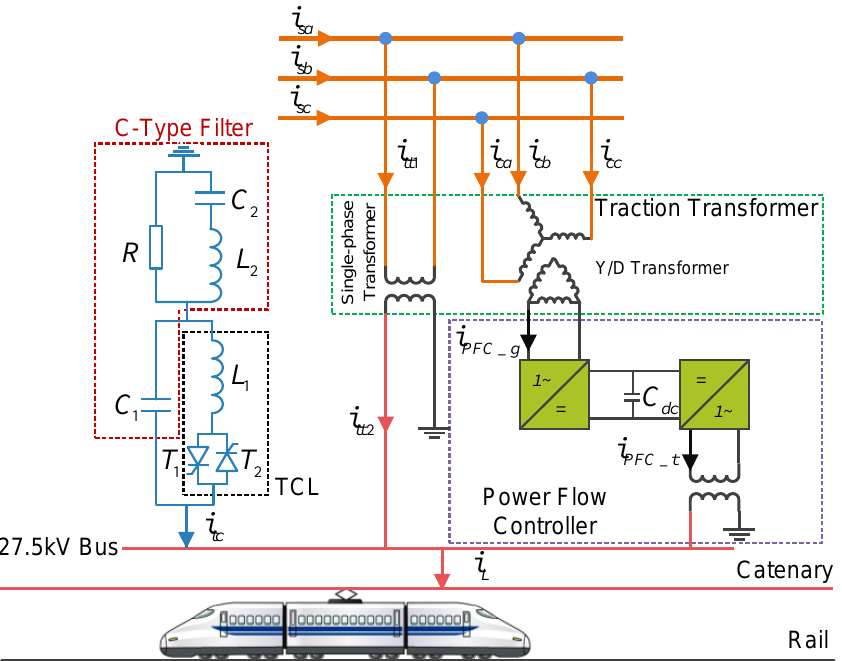
Figure 1. Circuit configuration of the hybrid power quality compensation system.